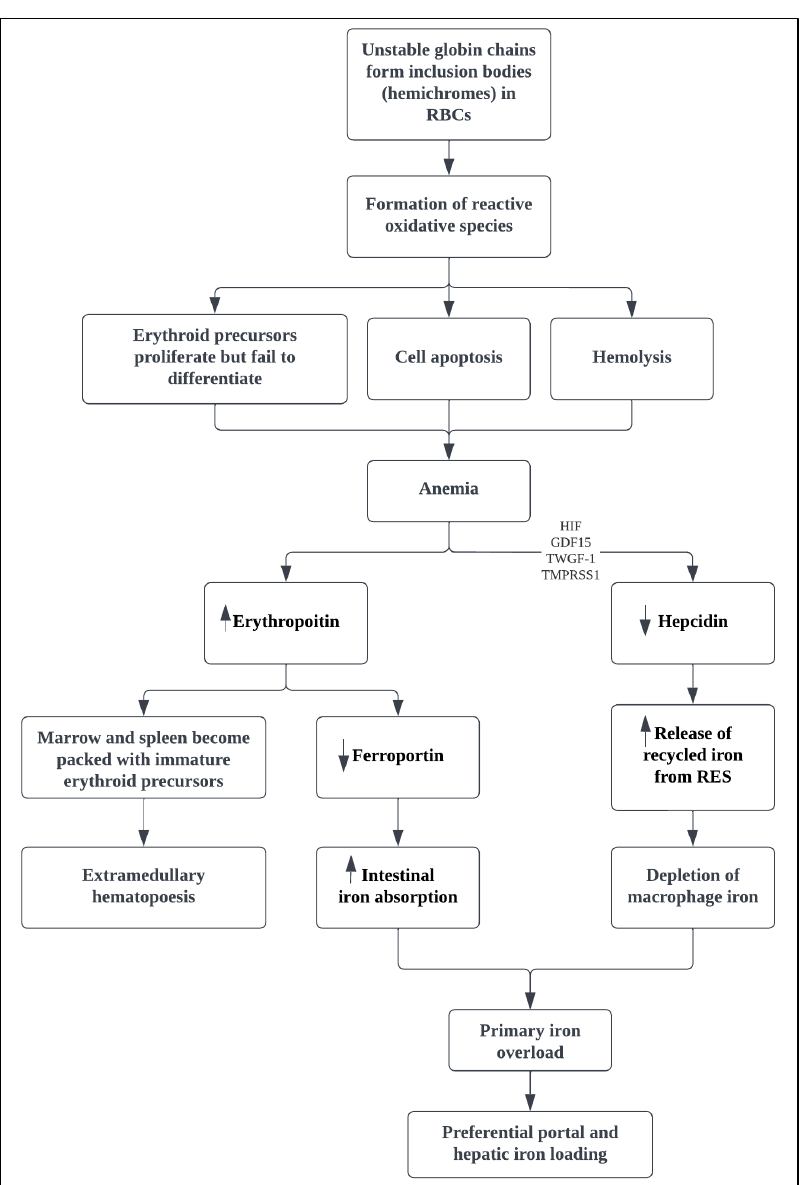
Figure 1. Pathophysiologic mechanisms in NTDT. GDF-15: growth differentiation factor 15; HIF: hypoxia-inducible transcription factors; NTDT: non-transfusion dependent thalassemia; RBCs: red blood cells; RES: reticuloendothelial system; TWGF-1: twisted gastrulation factor-1; TMPRSS6: transmembrane protease serine 6.